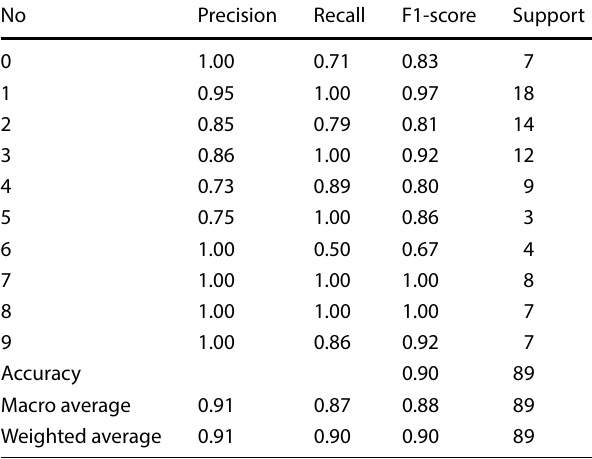
Table 4 Decision Tree (DT) result using the Confusion Matrix No